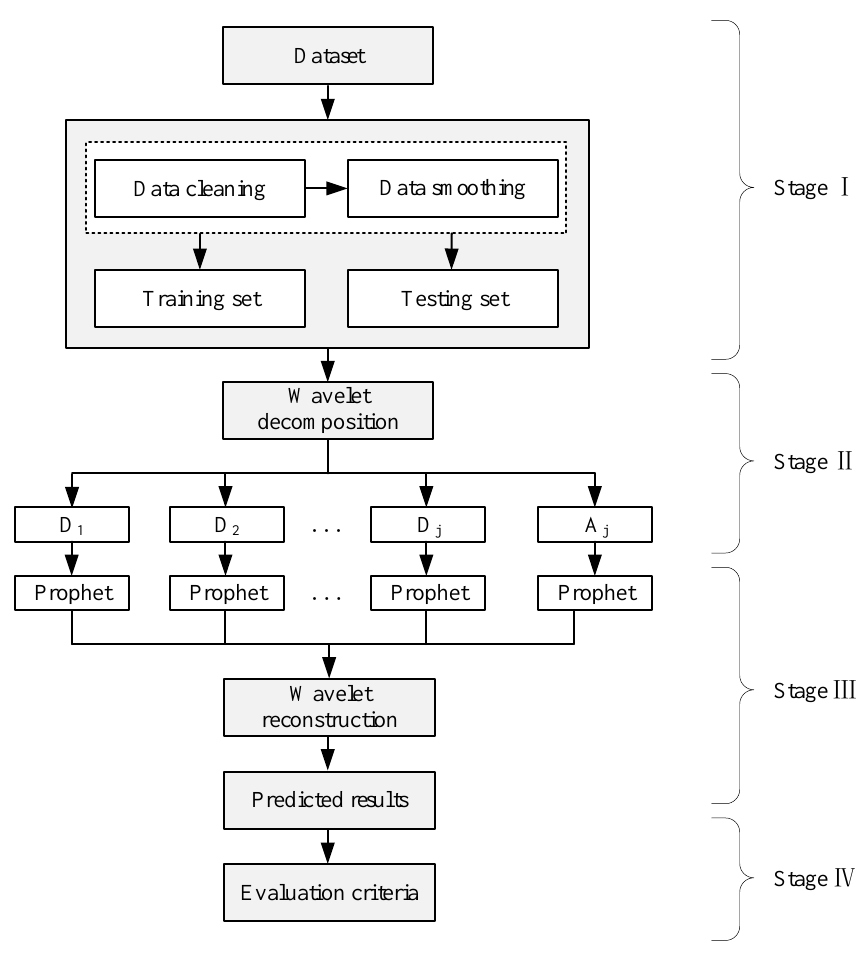
Figure 3. Flow chart of the combination model prediction.